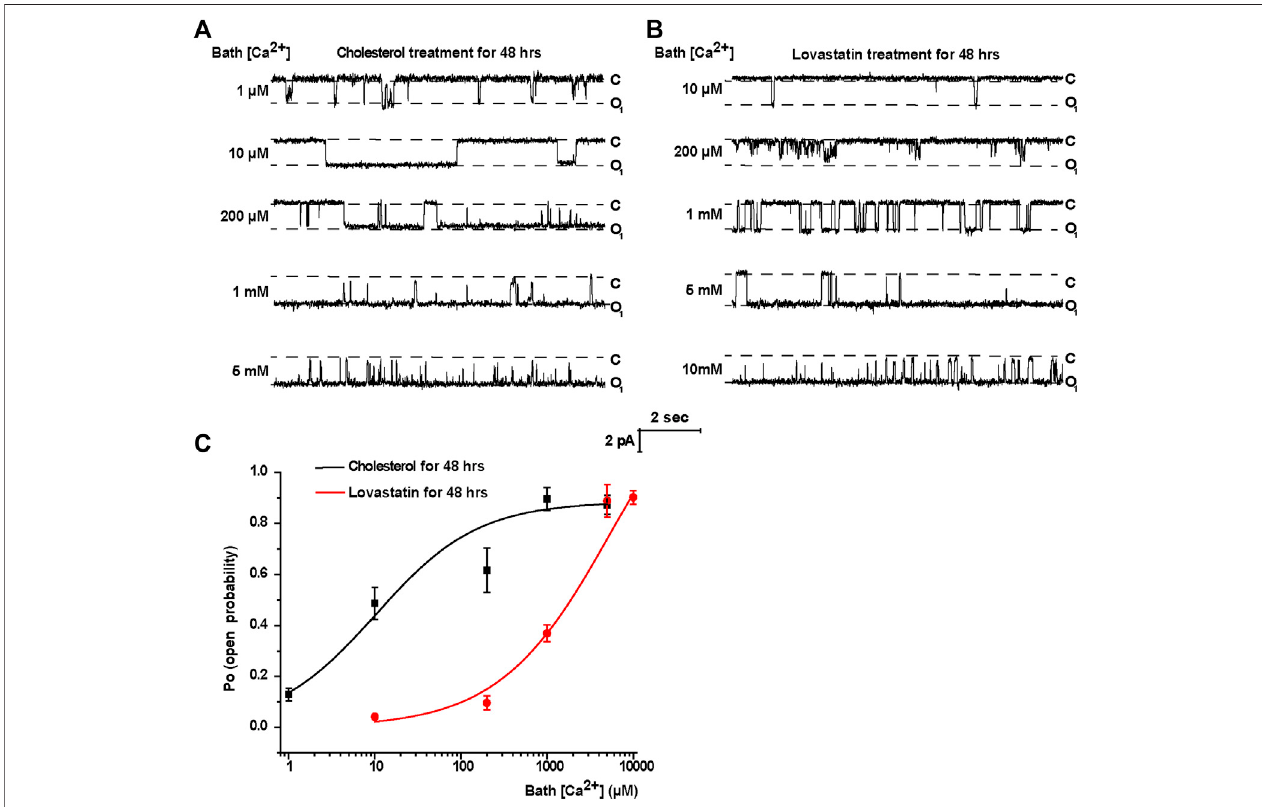
FIGURE 2 | Treatment of cells with cholesterol increases, but with lovastatin decreases, TRPM4 channel activity by regulating its sensitivity to Ca 2+ in mpkCCD c14 Cells. (A) Representative single channel recording from inside-out patches exposed the patch membrane to the bath containing different concentrations of free Ca 2+ . The cells were treated with 30 μ g/ml cholesterol for 48 hrs. From top to bottom: 1 μ M, 10 μ M, 200 μ M, 1 mM, and 5 mM free bath Ca 2+ . “ C ” indicates channel at the closed state; “ O ” indicates single-level openings. (B) Representative single channel recording from inside-out patches exposed the patch membrane to the bath containing different concentrations of free Ca 2+ . The cells were treated with 5 μ M lovastatin for 48 hrs. From top to bottom: 10 μ M, 200 μ M, 1 mM, 5 mM and 10 mM free bath Ca 2+ . “ C ” indicates channel at the closed state; “ O ” indicates single-level openings. (C) The effect of membrane cholesterol on Ca 2+ -dependence of channel opening.Channel P O wasplottedasafunctionoffreeCa 2+ concentrationinthebath. P ovaluesareshownforpatcheseitherwithexogenouscholesteroltreatment(black line) or lovastatin treatment (red line). n (cid:2) 4 – 7 cells for different data